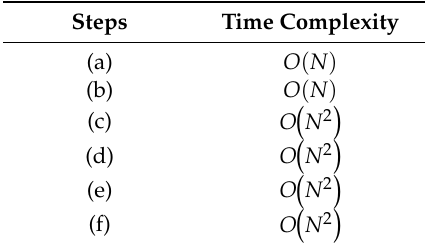
Algorithm 1 runs iteratively for increasing N values, where N is the size of a node set in the DBTRN. Table 3 shows the time complexity of the main steps of Algorithm 1. Table 3. Time complexity of each